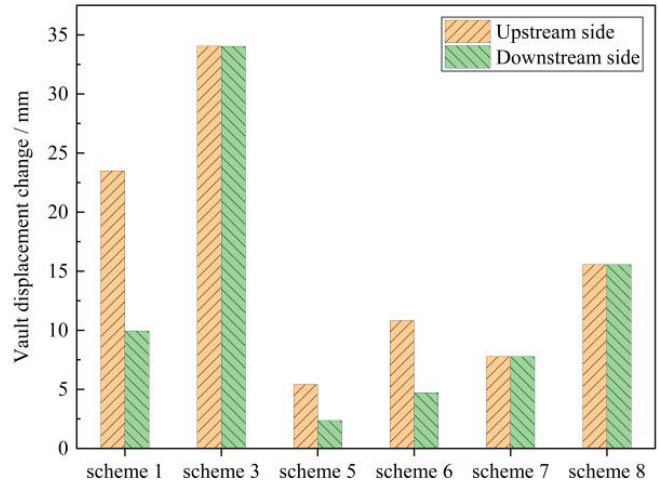
Figure 9. Displacement of the main arch crown.